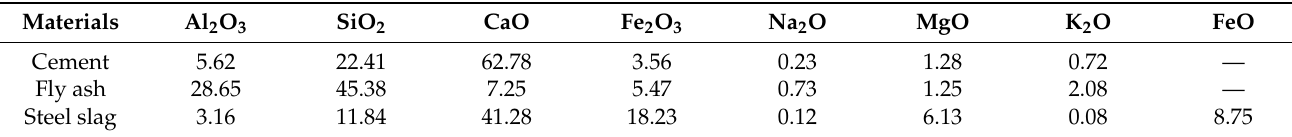
Table 1. Chemical composition of materials (%).